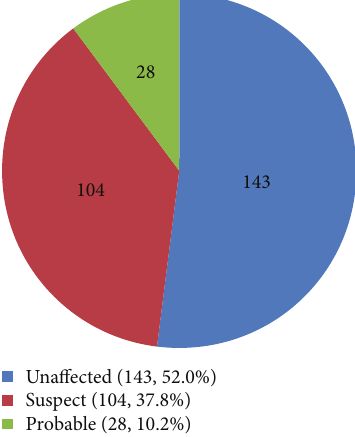
Figure 3: Numbers of cases of congenital rubella syndrome status based on revised Center for Disease Control